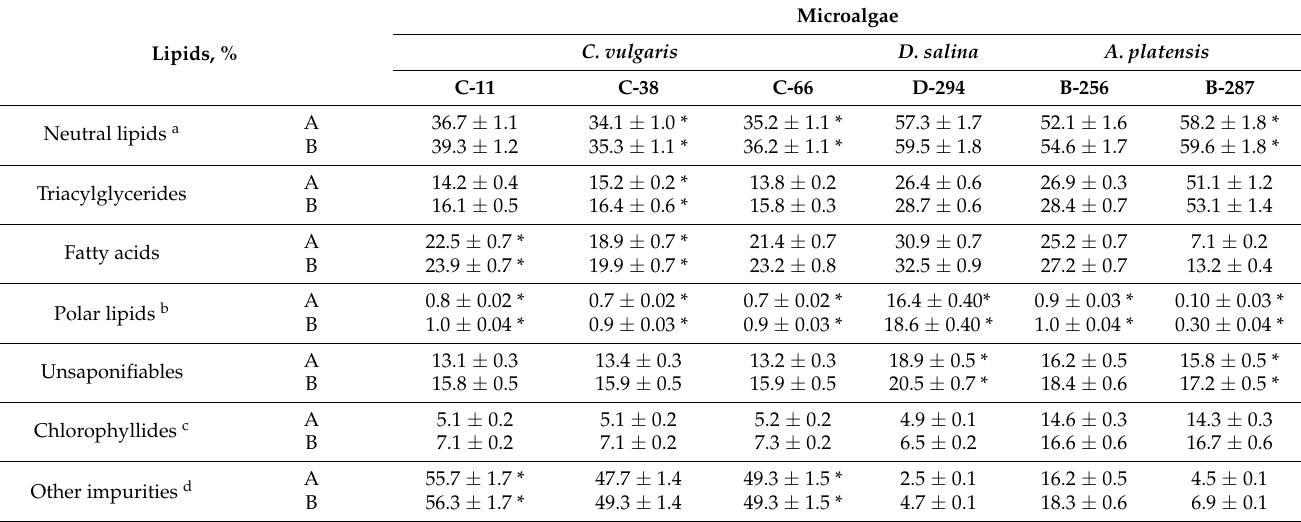
Table 7. The lipid species composition of microalgae of 100 g microalgae without (A) and with (B) the addition of carbohydrates.